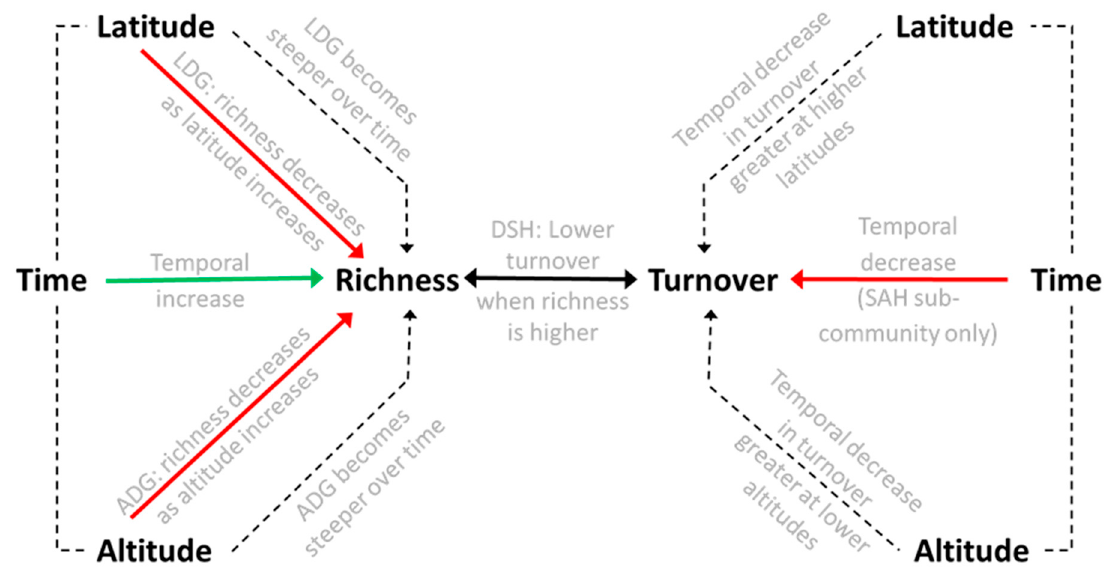
Figure 6. Summary of patterns between taxonomic richness and within-site turnover relative to spatiotemporal variables (time, latitude, altitude). Solid lines denote direct effects, dashed lines denote indirect effects where one factor mediates relationships between other variables. LDG = Latitudinal Diversity Gradient; ADG = Altitudinal Diversity Gradient; DSH = Diversity Stability Hypothesis; SAH sub-community = shrub and herb sub-community.